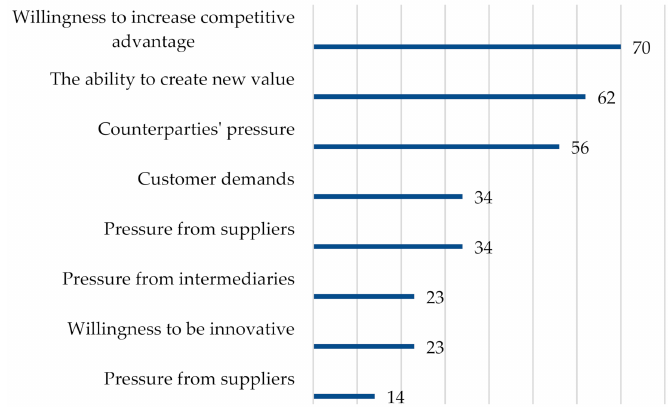
Figure 5. Motivation for the decision to implement Industry 4.0 technology.